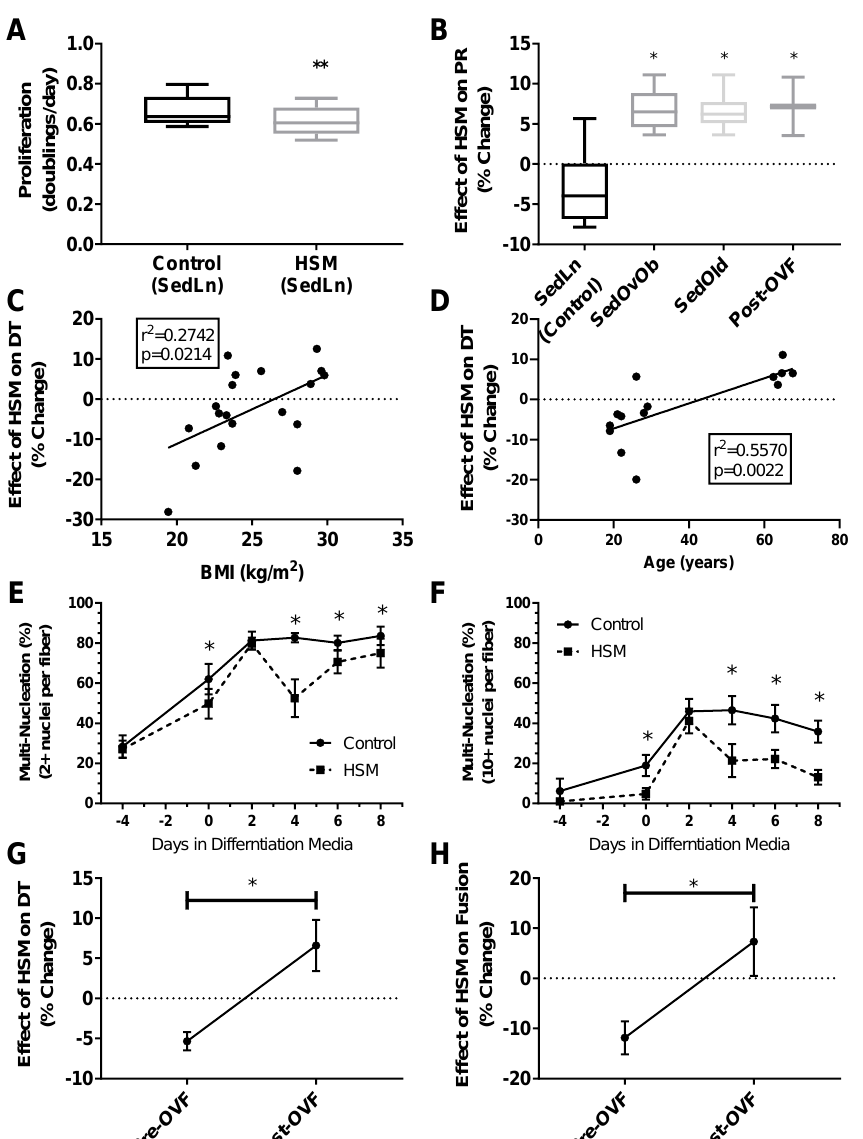
Figure 5. Proliferation rates (doubling/day) of satellite cells (SCs) isolated form sedentary lean (SedLn) ( n = 10, BMI 18 – 25 kg/m 2 ) participants treated with control vs. high substrate media (high substrate media (HSM), +400 mM, 2:1, oleate – palmitate, +20 mM glucose) ( A ). Response of SedLn ( n = 10), sedentary overweight/obese (SedOvOb) ( n = 5), post overfeeding (post-OVF) ( n = 4) and sedentary old (SedOld) ( n = 5). Effect (% change) of HSM media on SC proliferation rate (PR) of SedLn ( n = 10), SedOvOb ( n = 5), post-OVF ( n = 4) and SedOld ( n = 5) ( B ) groups, and correlated to SC donor BMI (SedLn, C) and age (SedLn and SedOld, ( D )). Fusion index scores ( C ), 2+ nuclei per fiber ( E ), 10+ nuclei per fiber ( F ) of SC from SedLn donors treated with control or HSM media. Effect (% change) of HSM on proliferation rate ( G ) and eighth-day fusion index scores ( H ) on SC collected pre-OVF/post-OVF ( n = 4/4). (*, **, *** indicating a p -value of <0.05, <0.01, <0.001, respectively).